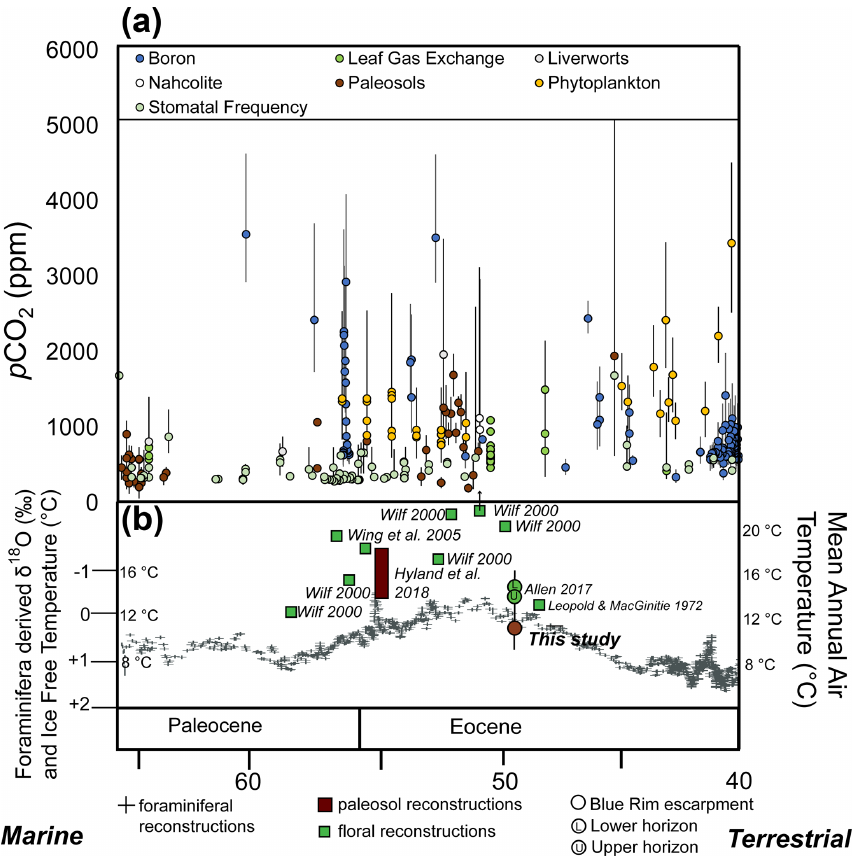
Figure 11. Paleoclimate reconstructions from the Blue Rim escarpment in the context of the evolution of climate from 66 to 40Ma. (a) p CO 2 from 66 to 40Ma based on multiple proxies compiled on paleo-CO 2 .org (McElwain, 1998; Ekart et al., 1999; Pearson and Palmer, 2000; Royer et al., 2001; Greenwood et al., 2003; Royer, 2003; Pagani et al., 2005; Lowenstein and Demicco, 2006; Fletcher et al., 2008; Zachos et al., 2008; Franks and Beerling, 2009; Retallack, 2009; Bijl et al., 2010; R. Y. Smith et al., 2010; Grein et al., 2011; Pagani et al., 2011; Hyland and Sheldon, 2013; Hyland et al., 2013; Huang et al., 2013; Franks et al., 2014; Maxbauer et al., 2014; Jagniecki et al., 2015; Anagnostou et al., 2016; Barclay and Wing, 2016; Liu et al., 2016; Kowalczyk et al., 2018; Witkowski et al., 2018; Zhang et al., 2018; Milligan et al., 2019; Steinthorsdottir et al., 2019; Haynes et al., 2020; Henehan et al., 2019, 2020). (b) Marine δ 18 O and ice-free temperature reconstructions based on foraminiferal data (Zachos et al., 2008) and mean annual air temperatures reconstructed from physiognomic (green) and paleosol (brown) proxies in the Paleocene and Eocene. Error bars are from the paleo-CO 2 .org site and associated citations; how they were calculated can be found in these